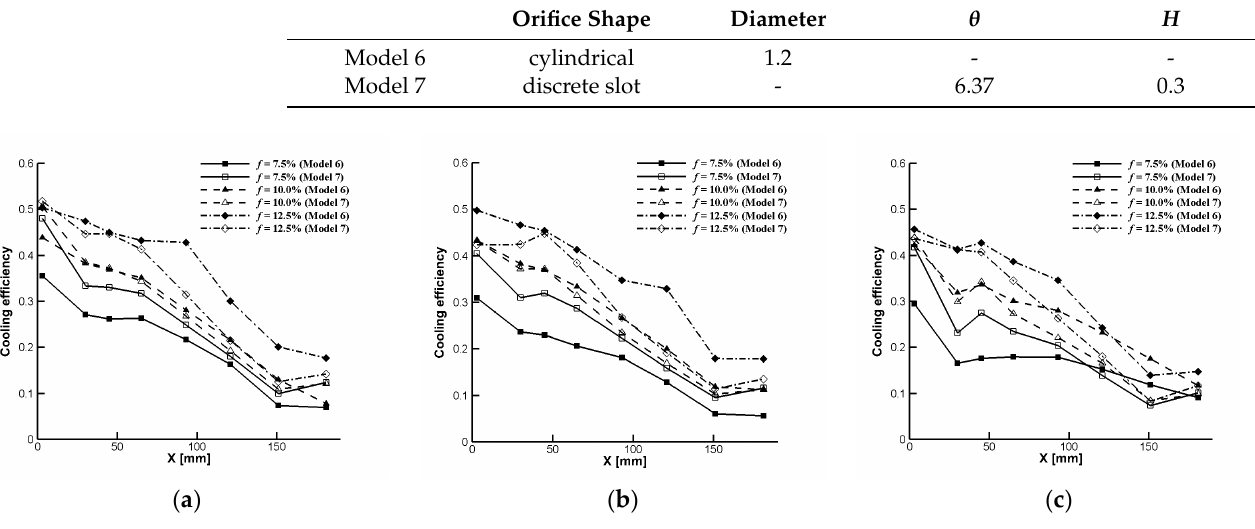
Figure 11. Comparison of film cooling efficiency in Models 6 and 7. ( a ) α = 0°. ( b ) α = 15°. ( c ) α = 30°.